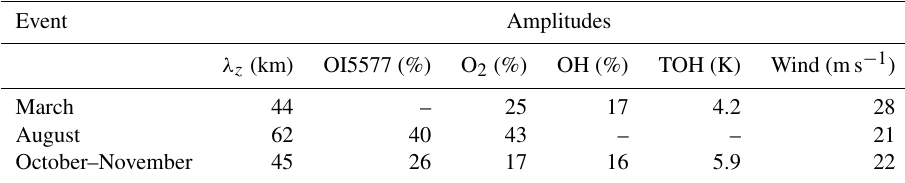
Table 2. Characteristics of the 3–4-day oscillations observed simultaneously in the airglow and wind.